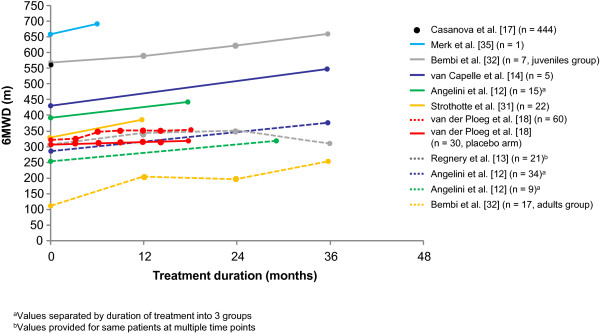
6MWD in healthy adults and late-onset Pompe patients (untreated and those receiving treatment) [[37]]. 6MWD in healthy adults (black dot) [17], untreated late-onset Pompe patients (red line, data extracted from van der Ploeg et al. [18]), and across several studies of Pompe patients receiving alglucosidase alfa treatment [12-14,18,31,32,35]. Adapted with permission from [37] © 2013, Springer Science + Business Media. 6MWD, 6-minute walking test distance.